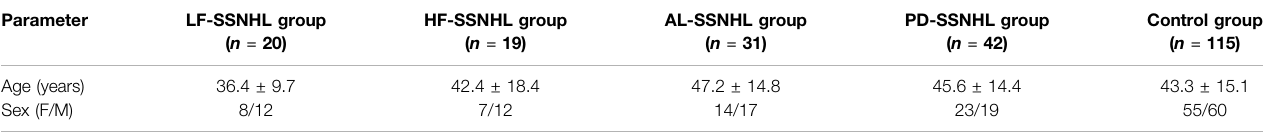
TABLE 1 | Clinical features and demographic characteristics in SSNHL patients and healthy